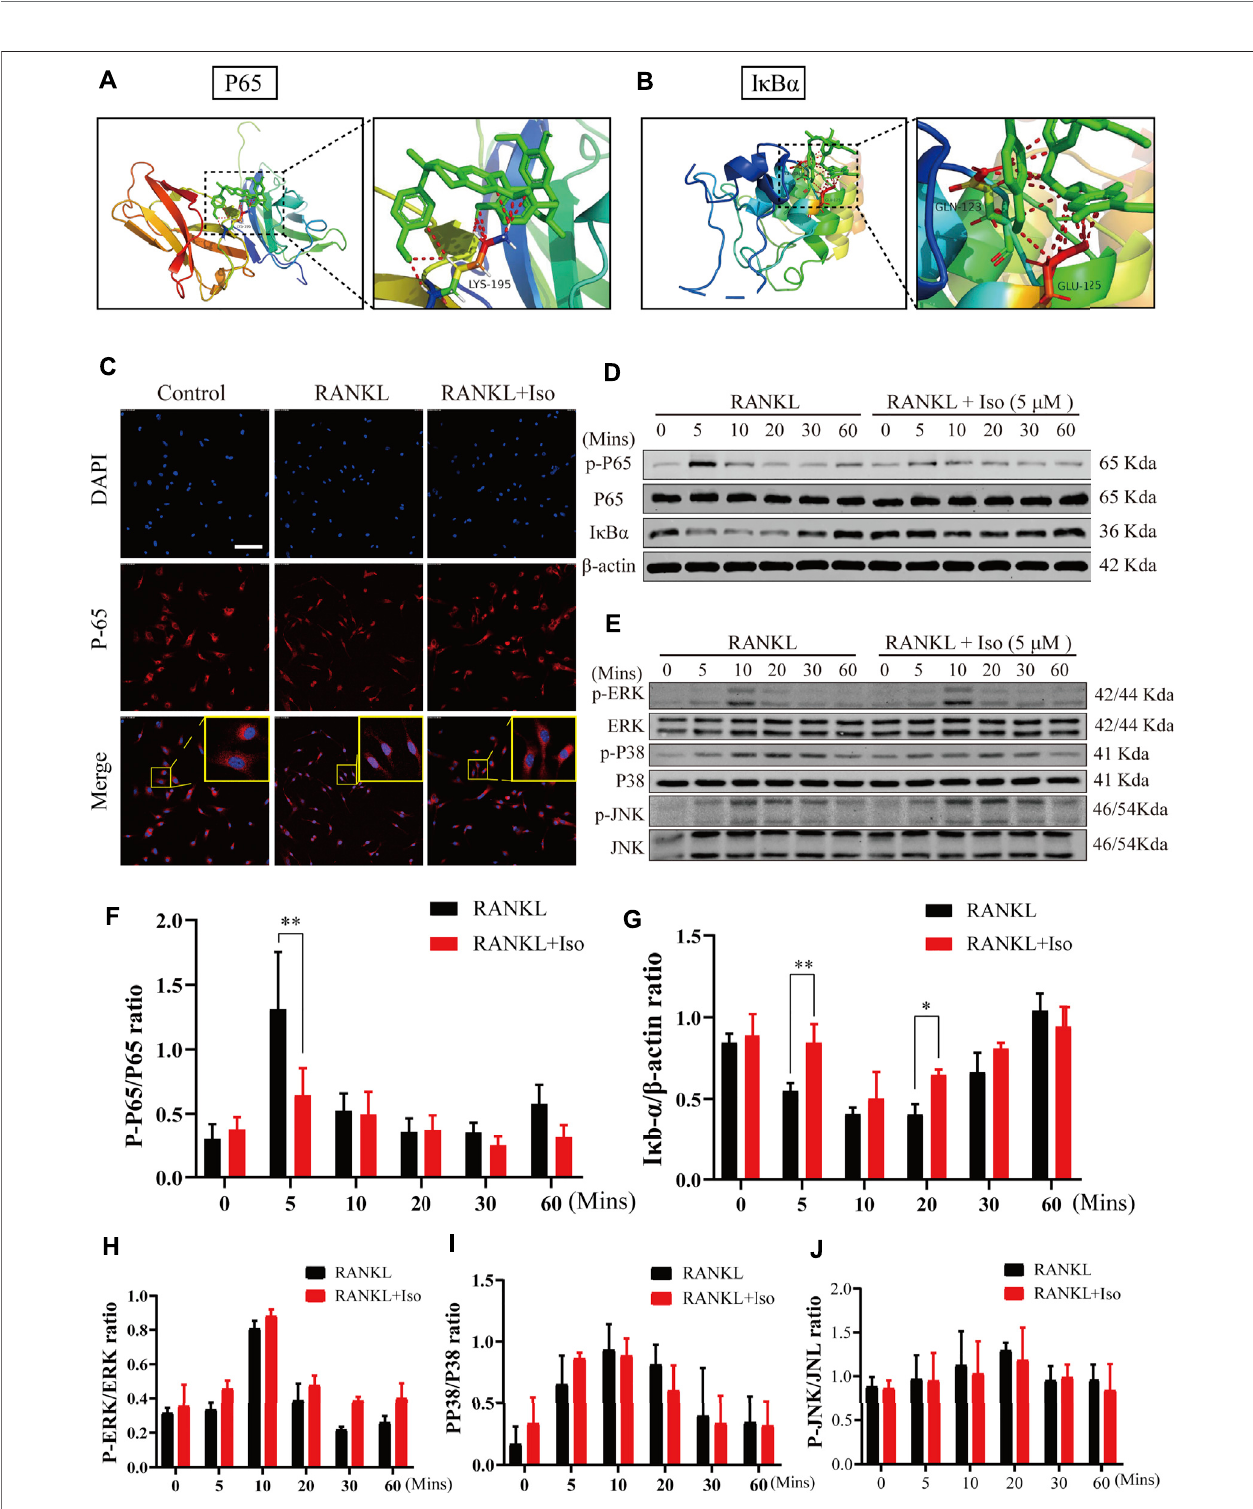
FIGURE 5 | Iso abolishes RANKL-induced activation of NF- κ B signaling pathways, but does not suppress MAPK pathway during osteoclastogenesis. (A,B) Molecular docking showed that Iso could bind with P65 and I κ B α in NF- κ B pathway (C) Immuno fl uorescence images of p65 nuclear translocation following RANKL stimulation without or with 5 μ M Iso treatment (Magni fi cation = ×20, scale = 100 μ M). Cell nuclei were counterstained with DAPI. (D,E) Representative western-blot images of protein expression and phosphorylation status of p65, I κ B α , ERK, JNK and p38 (F – G) The expression of proteins above was quantitatively analyzed standardized to β -actin (H – J) The expression levels of P38, ERK, JNK. All data are expressed as mean ± SD. * p < 0.05, ** p < 0.01, *** p < 0.001.